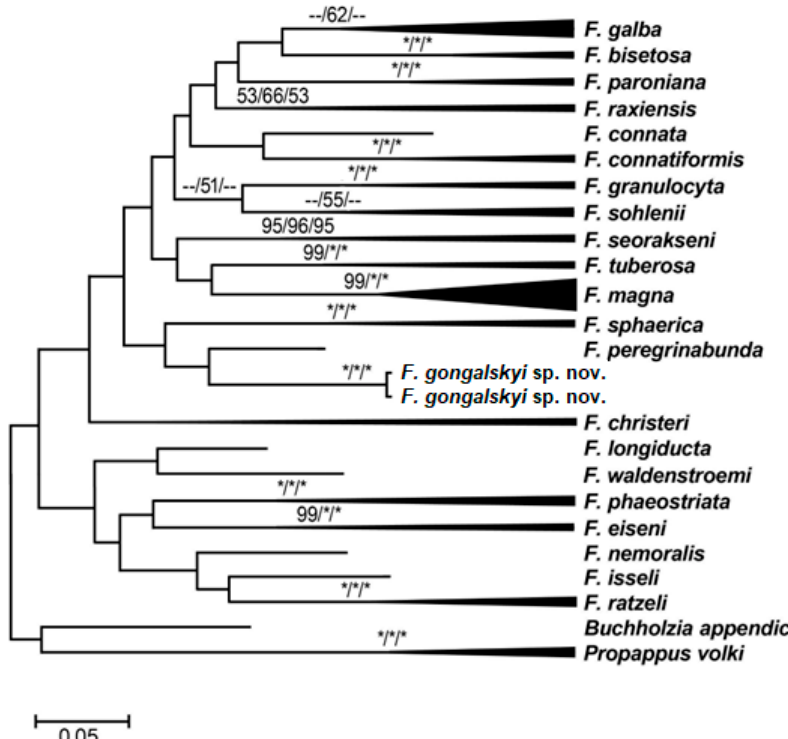
Figure 4. Reconstruction of the phylogenetic relationships of representatives of the genus Fridericia based on the variability of the COI fragment (522 bp) carried out by the maximum likelihood method in accordance with the GTR + G + I model of molecular evolution; +G, parameter = 0.72. The length of the branches is proportional to the genetic distances between haplotypes; bootstrap support (Felsenstein, 1985) is indicated next to the branching nodes, calculated on the basis of building trees using ML/NJ/MP methods from 1000 replicas (“*”—bootstrap support equal to 100%, “–” or not specified—bootstrap support less than 50%).